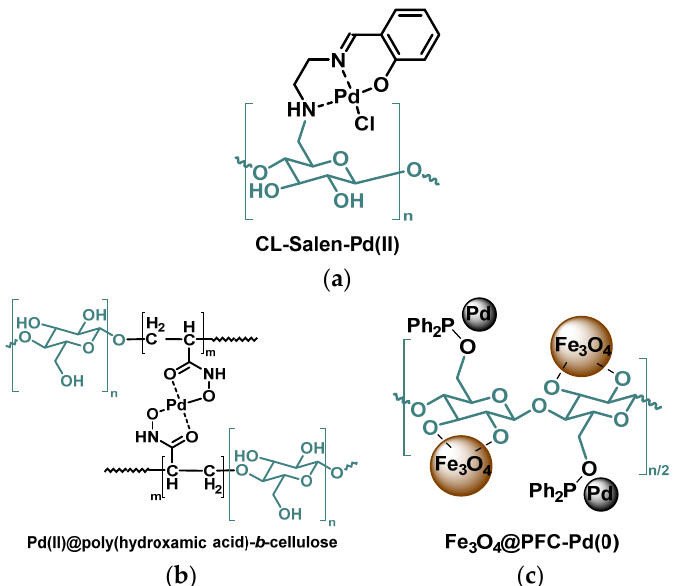
Figure 3. ( a ) Cellulose-salen-supported Pd(II) complex [32]; ( b ) Pd(II) complex supported by poly(hydroxamic acid) derivative of cellulose [34]; ( c ) Pd NPs supported by magnetic Fe 3 O 4 cellulose [40]. lose